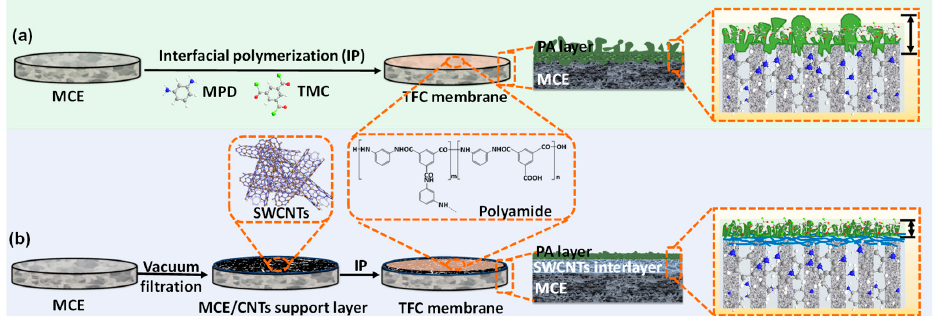
Figure 1. Schematic diagram of preparation process for TFC membrane. ( a ) TFC membranes with pristine MCE substrates; ( b ) TFC membranes with MCE/CNTs support layers.